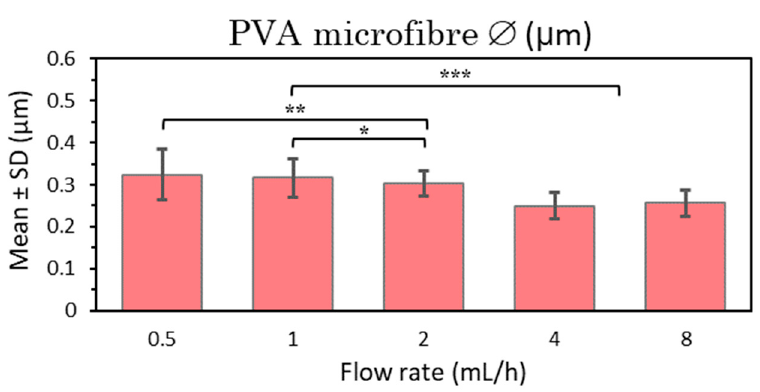
Figure 4. Mean and standard deviation of the diameters of 21% PVA microfibers manufactured at 15 cm, 15 kV, and 0.5, 1, 2, 4, and 8 mL/h., at (*) p < 0.05, (**) p < 0.01, (***) p < 0.001 statistically signi fi cant di ff erences.